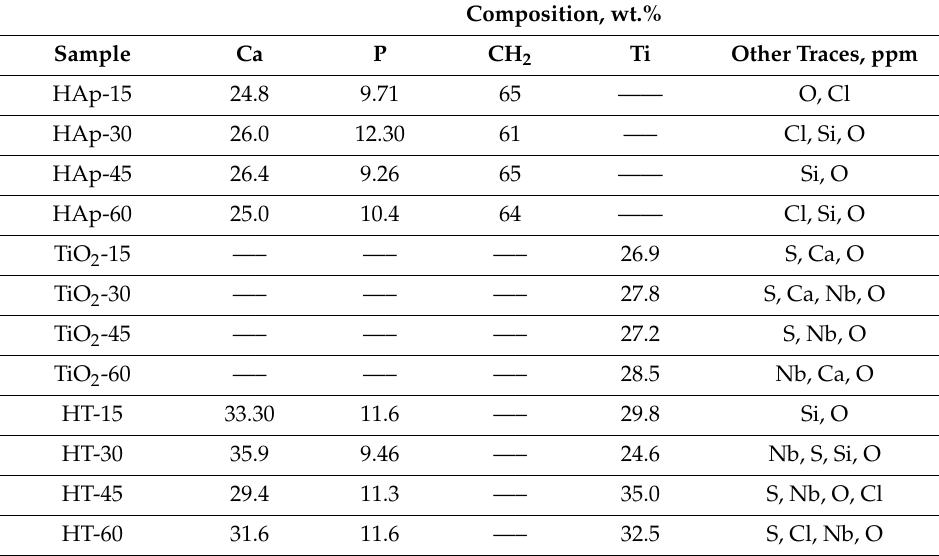
Table 2. Compositional analysis of nanoparticles obtained by the sol-gel method assisted by ultrasound